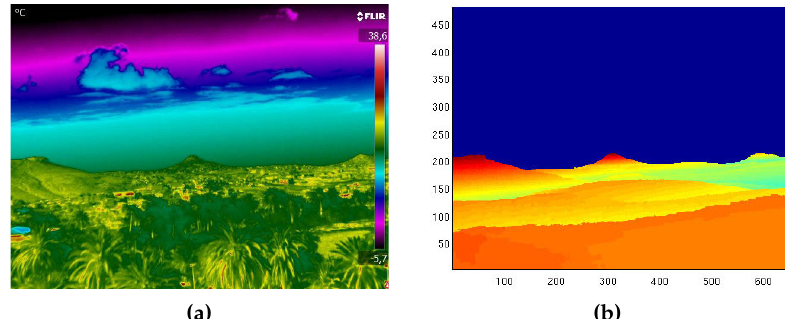
Figure 8. Final result and comparison of the thermographic and synthetic images after performing a terrain profile alignment. ( a ) Thermographic image. ( b ) Fully aligned synthetic image.